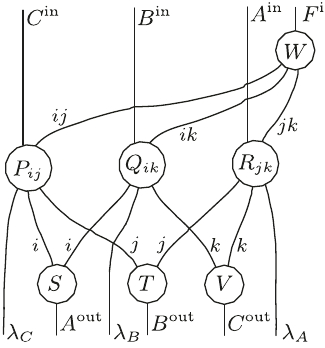
Fig. 9 Causally faithful extended circuit decomposition of the unitary U from Fig. 8. (Up to some swaps for better readability).